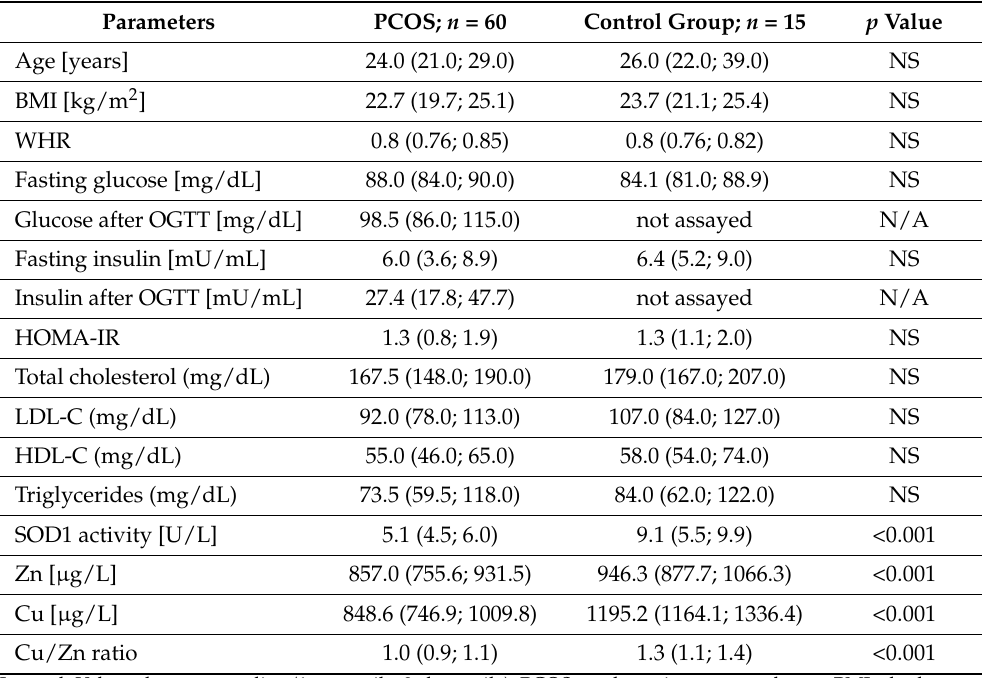
Table 1. Characteristics of women with and without